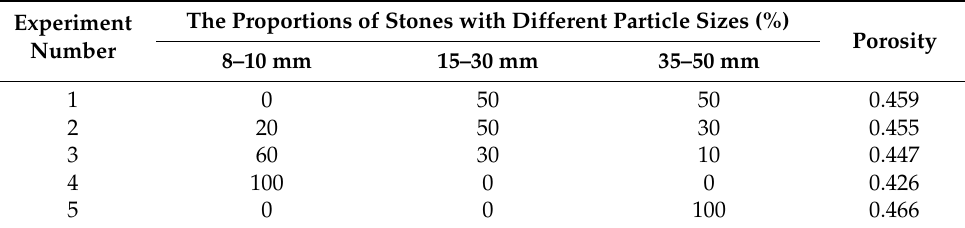
Table 3. The proportions of stones with different particle